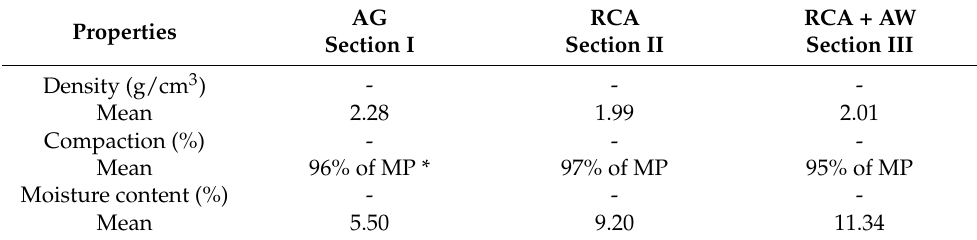
Table 7. In situ assessments of density and moisture of study